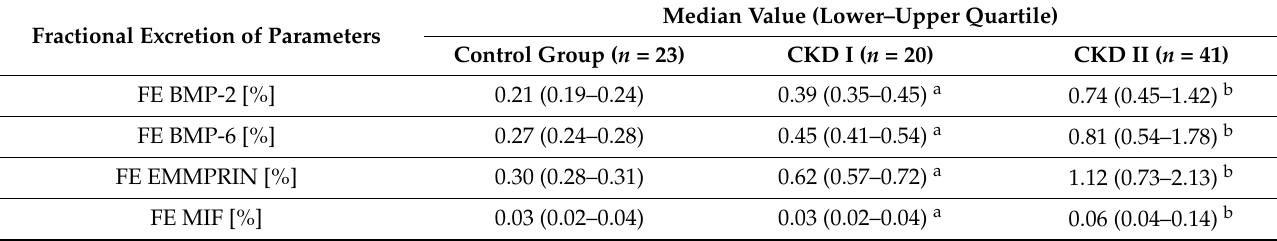
Table 4. Fractional excretion of examined parameters in children with CKD and in the control group.